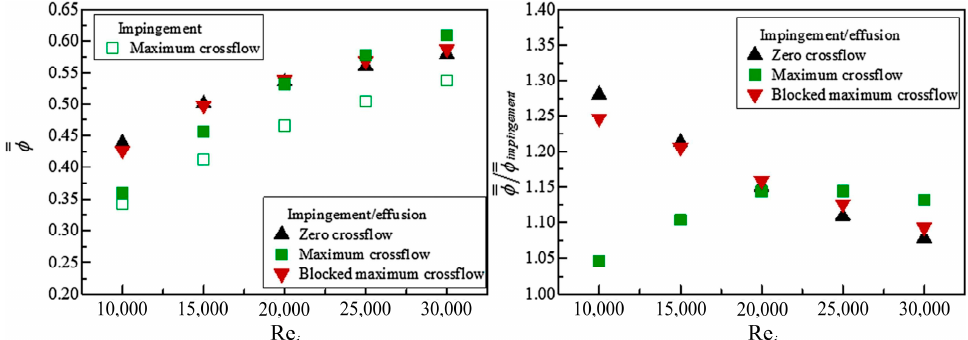
Figure 22. Comparisons of the area-averaged overall double-wall cooling efficiency and the area- averaged overall cooling efficiency ratios related to the pure impingement cooling. Reprinted with permission from [109]. Copyright 2019 Elsevier.